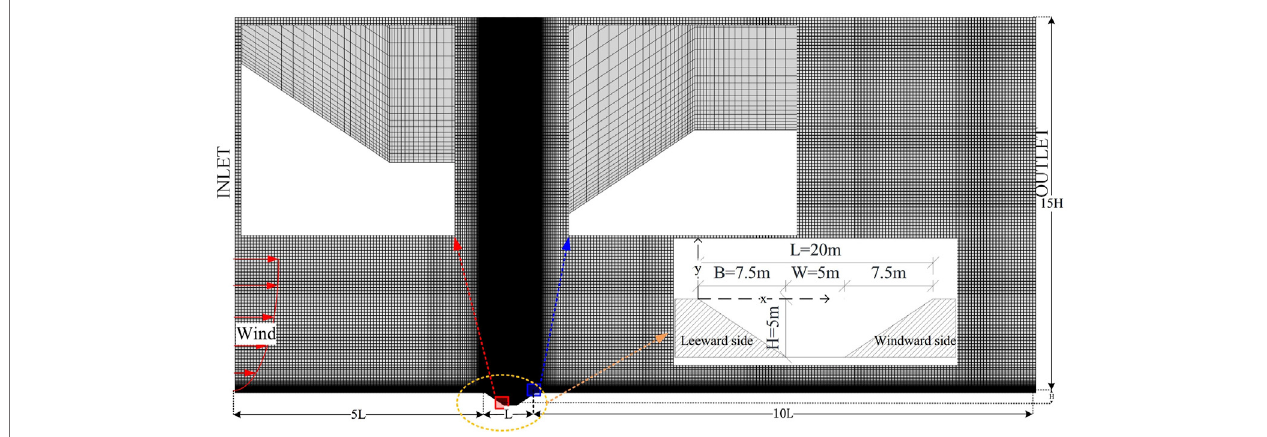
FIGURE 5| Numerical simulationmodel. The dimensionsand grid ofthe numerical model are shown in Figure 5 . The grid in the cutting, especially where the wind speed varies dramatically, is further re fi ned. In addition, the de fi ned coordinates in the cutting are shown in Figure 5